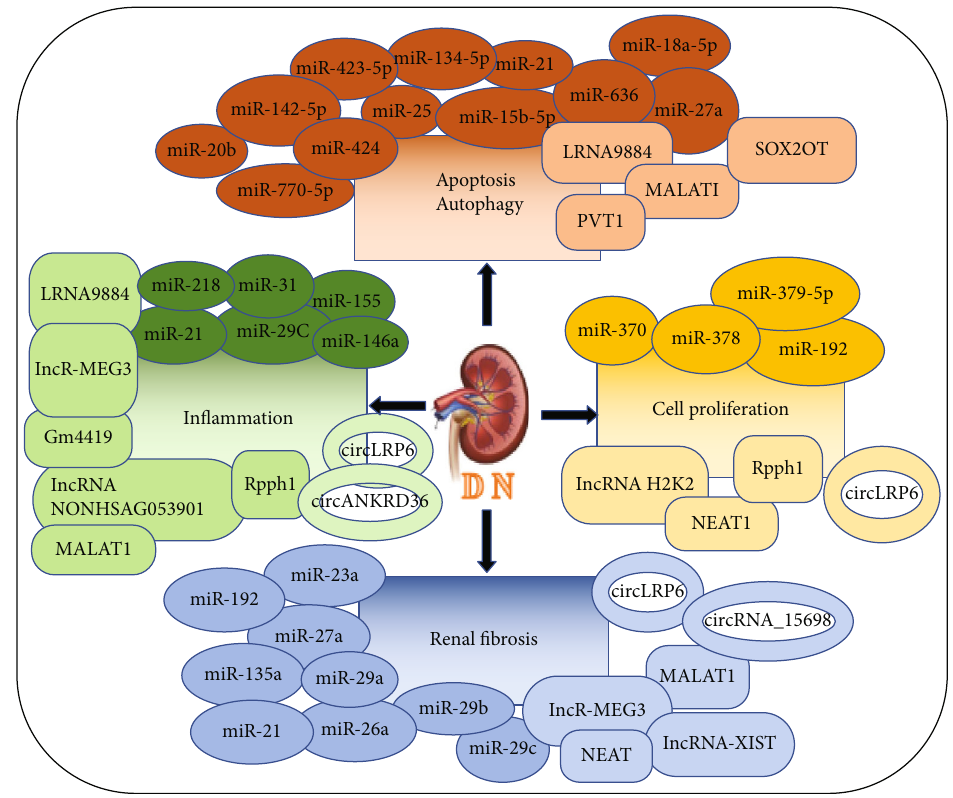
Figure 1: ncRNAs, including miRNAs, lncRNAs, and circRNAs, play important roles in regulating renal in fl ammation, apoptosis, autophagy, cell proliferation, and renal fi brosis in DN. The ellipse, the rectangle, and the ring, respectively, represent the miRNA, lncRNA, and